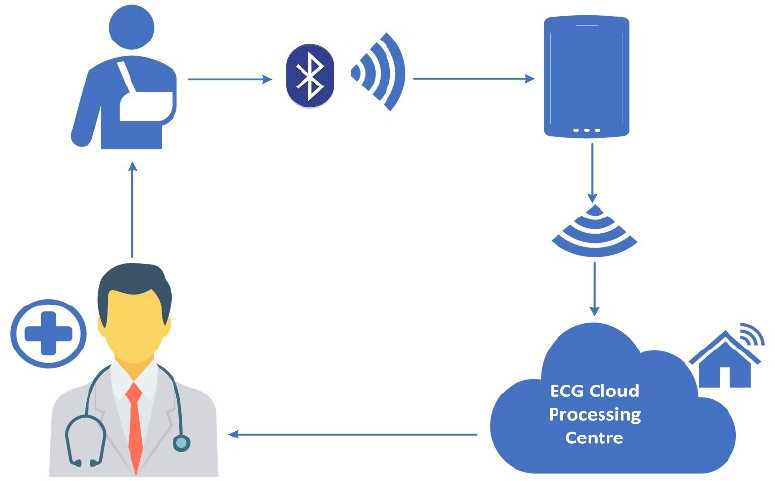
Figure 8. A generic design architecture of an ECG mobile application .